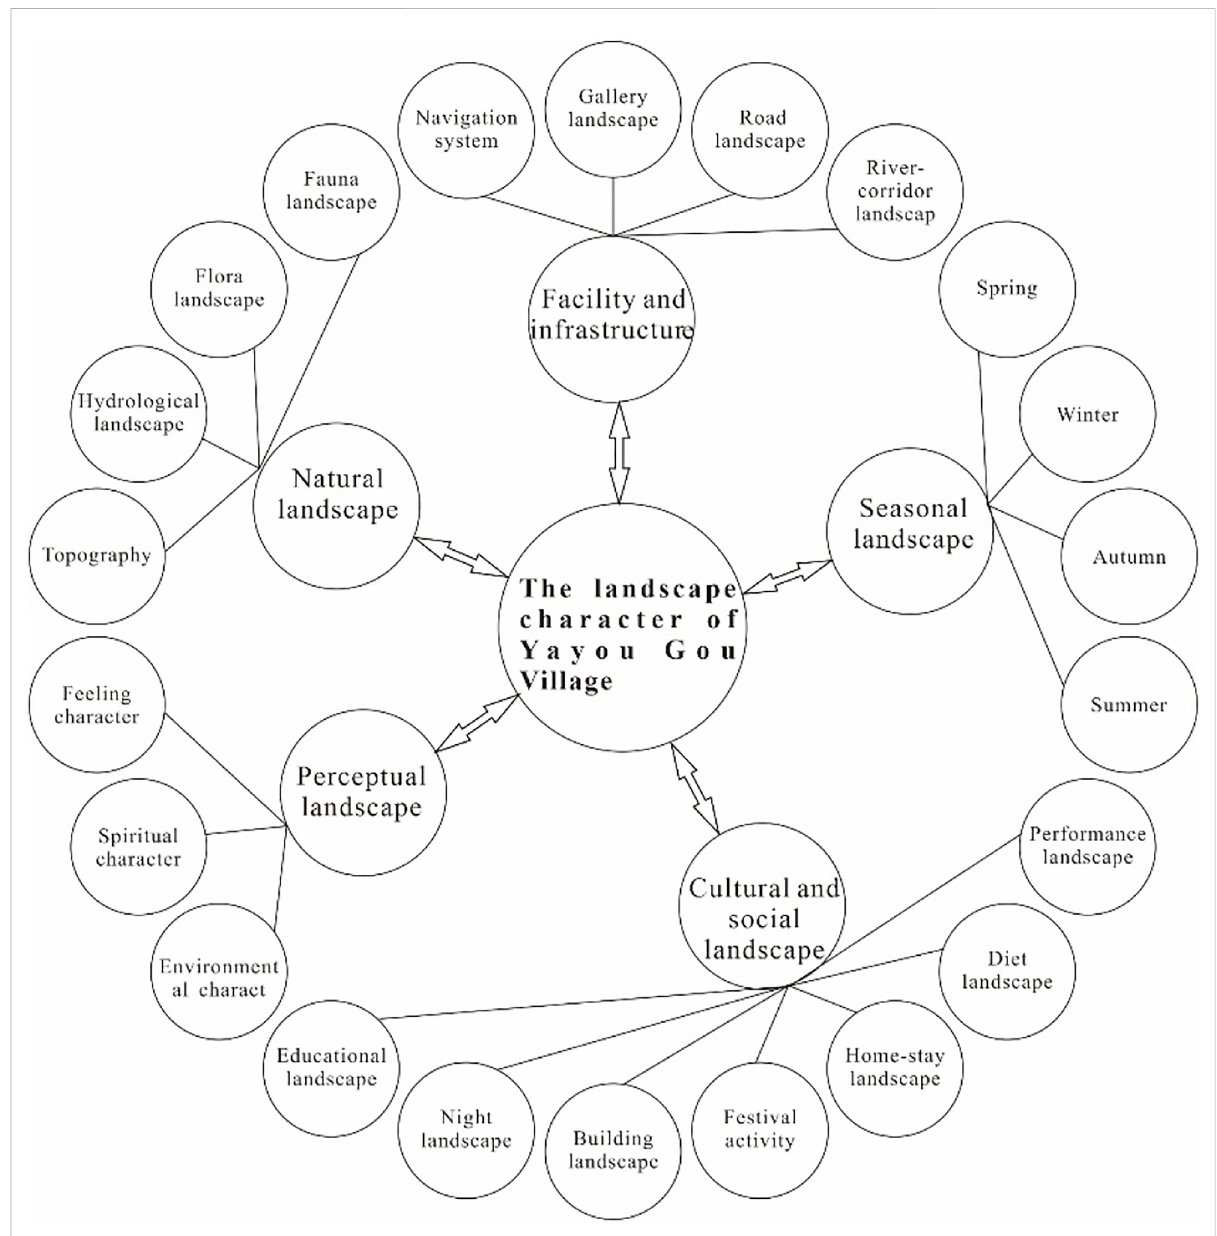
FIGURE 2 The secondary character of landscape in Yayou Gou